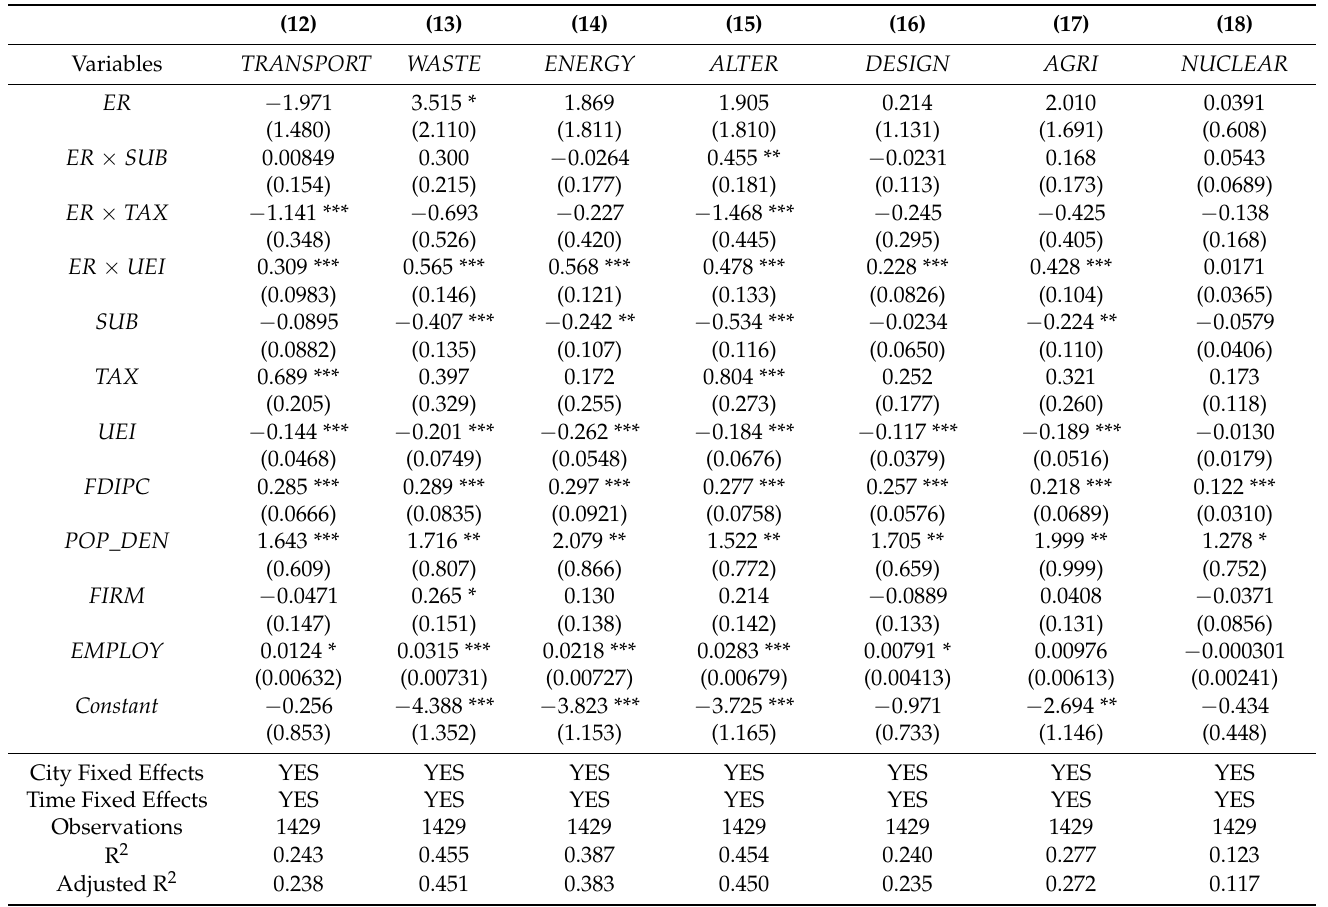
Table 4. Compound effects of government interventions across fields of